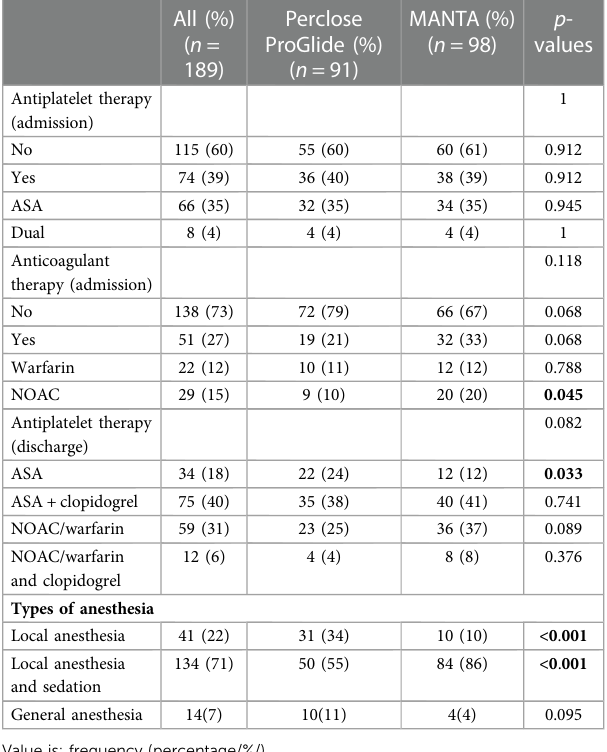
TABLE 4 Anticoagulant and antiplatelet therapy and types of anesthesia.